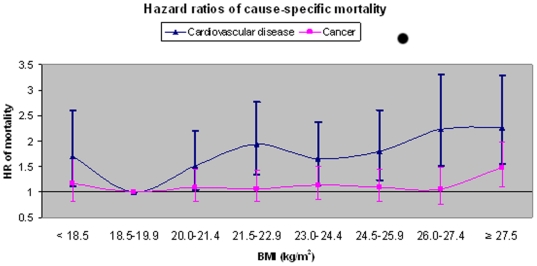
Hazard ratios of cause-specific mortality according to BMI.Hazard ratios of cause specific mortality in non-smokers without reported prevalent disease and excluding deaths occurring within 5 years of baseline (N = 30,538). Models adjusted for age, sex, year of enrollment, dialect, education, dietary pattern score and physical activity. Points represent hazard ratio (HR) point estimate and error bars represent 95% confidence intervals. P for linear association for cardiovascular disease  = 0.0001. P trend for linear association for cancer  = 0.04. Respective mortality counts for cancer and cardiovascular mortality by BMI (<18.5, 18.5–19.9, 20–21.4, 21.5–22.9, 23–24.4, 24.5–25.9, 26–27.4, ≥27.5): Cancer (58, 75, 130, 146, 146, 112, 64, 117), Cardiovascular disease (46, 39, 96, 139, 111, 99, 72, 95). Respective age & sex standardized mortality rates per 10,000 years follow up: Cancer (23, 18, 20, 20, 21, 21, 20, 29) and Cardiovascular disease (18, 9, 15, 19, 16, 19, 23, 23).